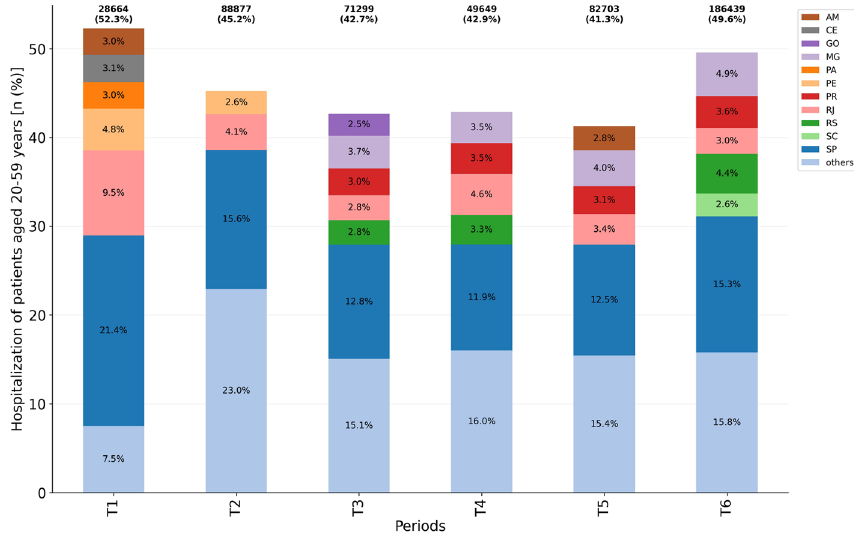
Figure 3. Hospitalization of patients aged 20–59 years among all age groups per considered period ( n = 507, 631 ). Federative units showing proportions ≥ 2.5 were highlighted while ‘others’ accounts for the grouping of those presenting a proportion < 2.5